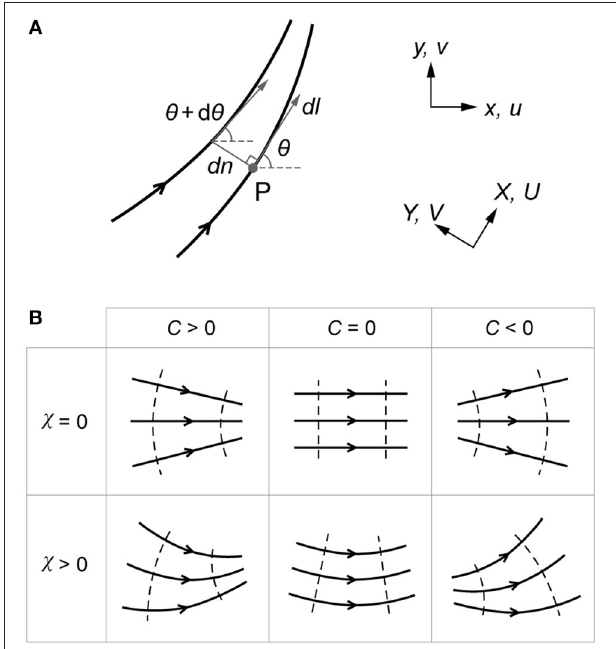
FIGURE 1 | (A) Symbols defining flowline geometry. (B) Convergence C and curvature χ for archetypal flow patterns. Adapted from Ng (2015).